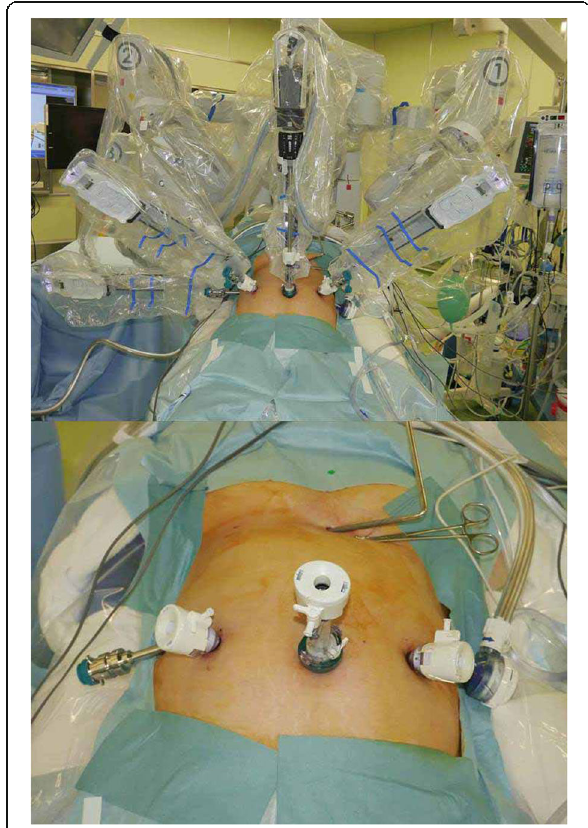
Fig. 2 Placement of trocars and robotic arms. Photographs showing the surgical setup in our